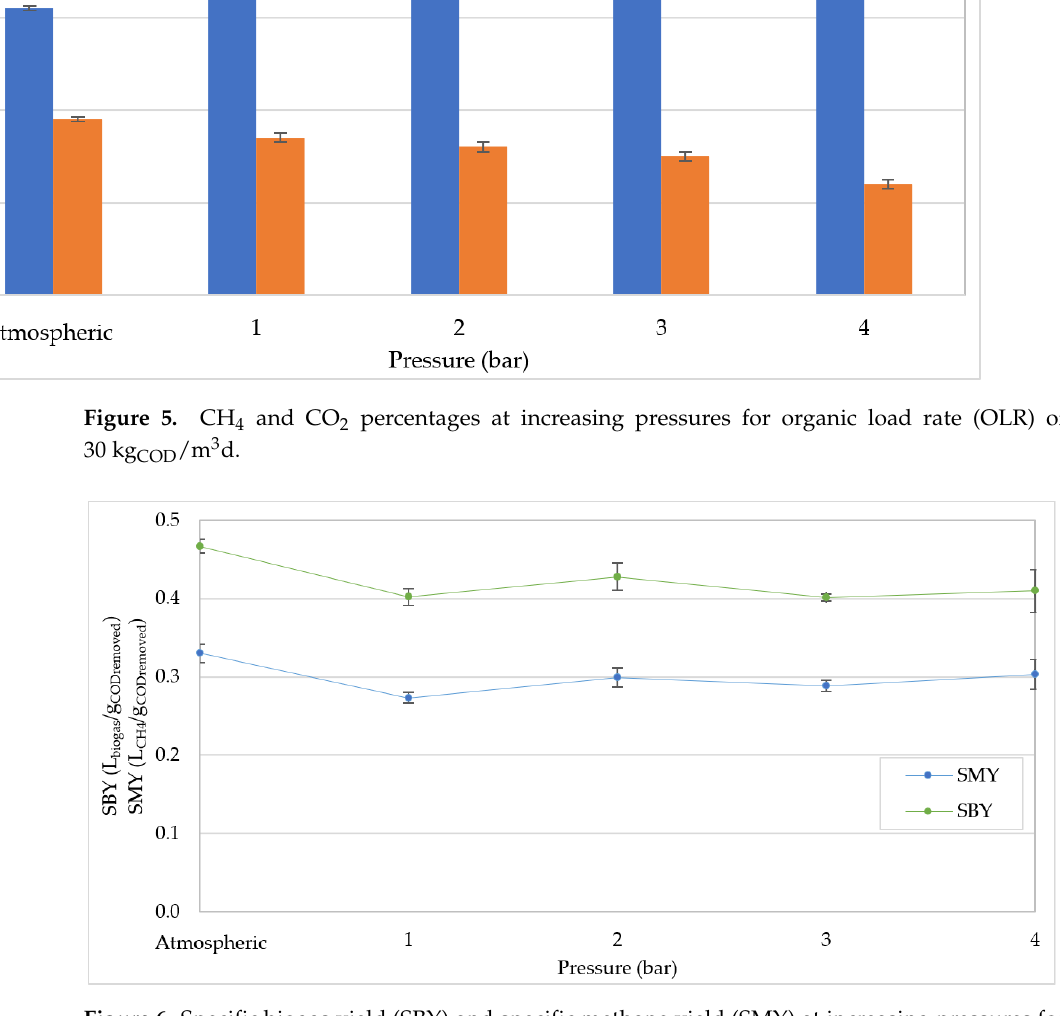
Figure 6. Specific biogas yield (SBY) and specific methane yield (SMY) at increasing pressures for 3 organic load rate (OLR) of 20 kg COD /m 3 d. organic load rate (OLR) of 20 kg COD /m